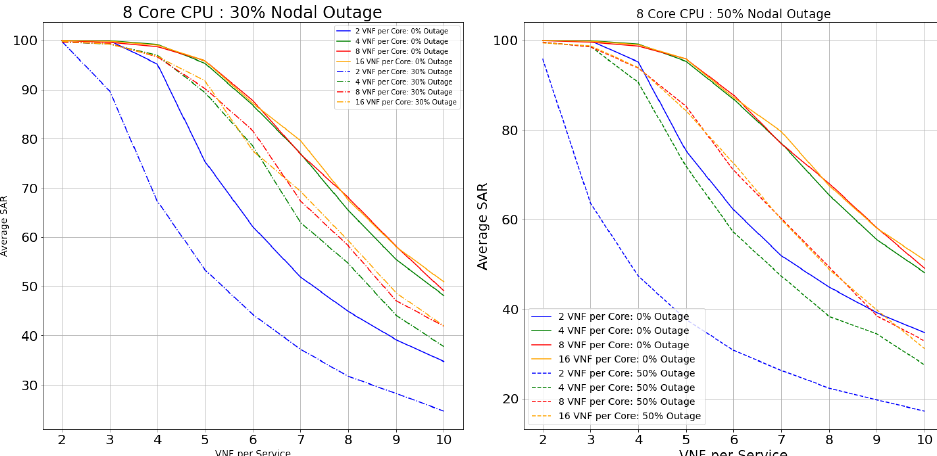
Figure 19. SAR: BtEurope topology with nodal outage—8 core CPU.